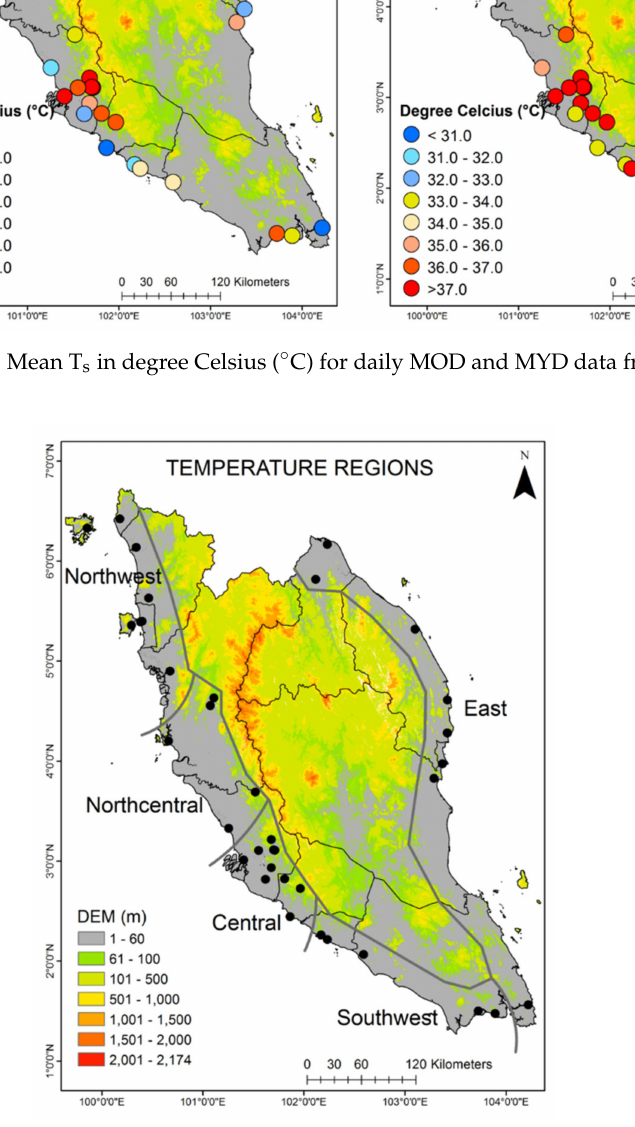
Figure 5. Map showing the lowland areas (0–60 m) along east and west coast regions, i.e., northwest, northcentral, central, southwest, and east